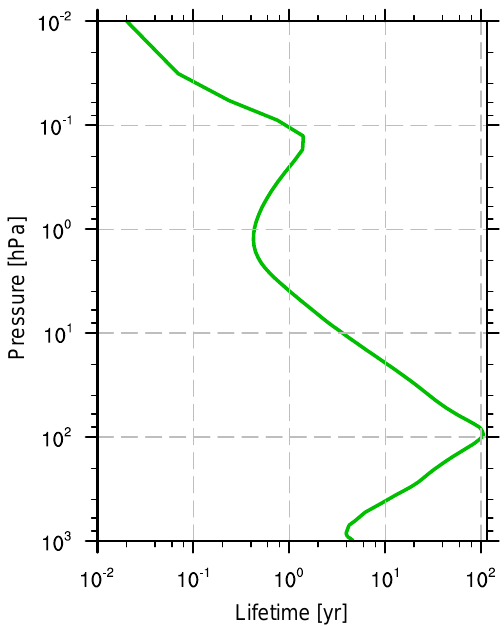
Figure 4. Vertical profile of CH 4 lifetime in the tropics with respect to removal by OH, O( 1 D), Cl and photolysis in